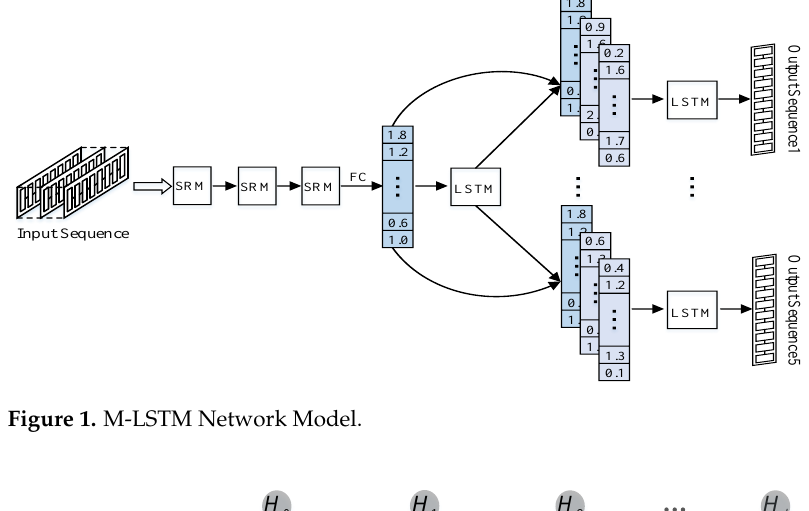
Figure 1. M-LSTM Network Model.